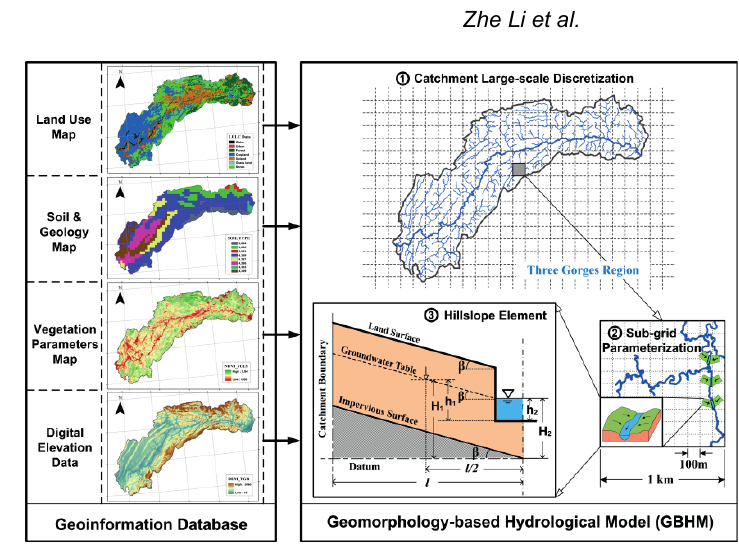
Fig. 3 Schematic diagram of GBHM for the Three Gorges Region.